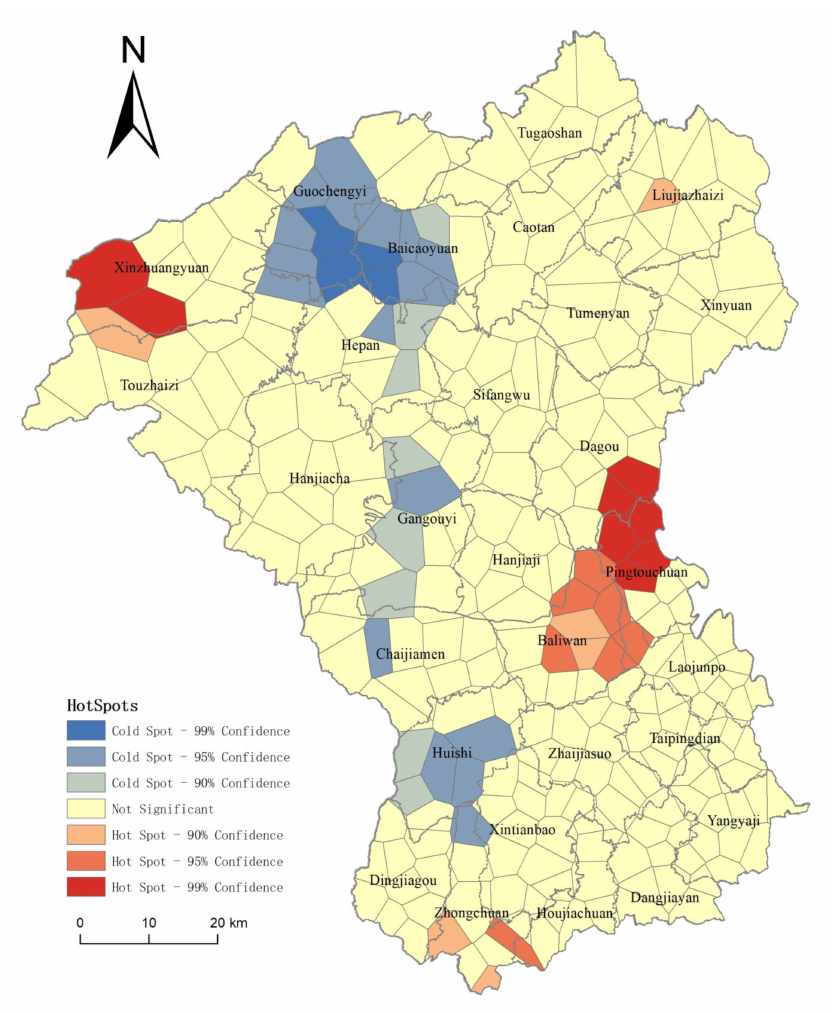
Figure 3. Spatial di ff erentiation of rural poverty rates in